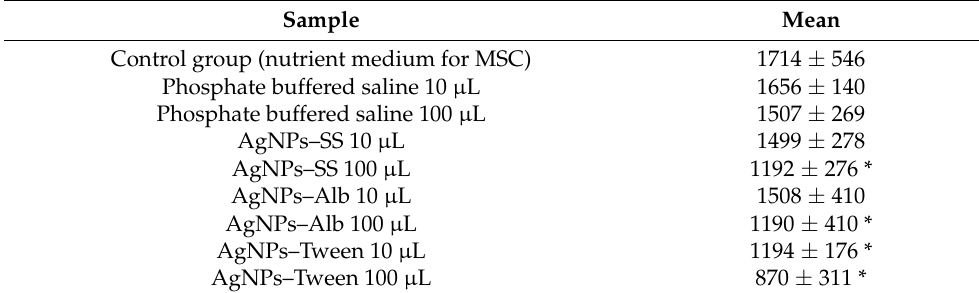
Table 2. Number of MSC nuclei on the surface of the cover glasses after cocultivation with different AgNP preparations (cells/mm 2 ).